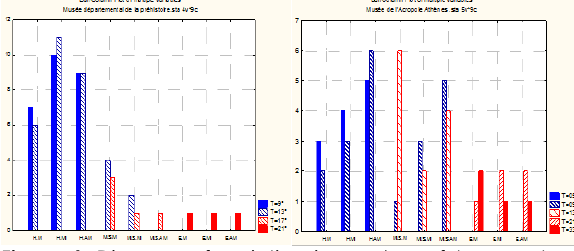
Figure 4 : Diagram of variation in number of temperature segments, daily and seasonal variations